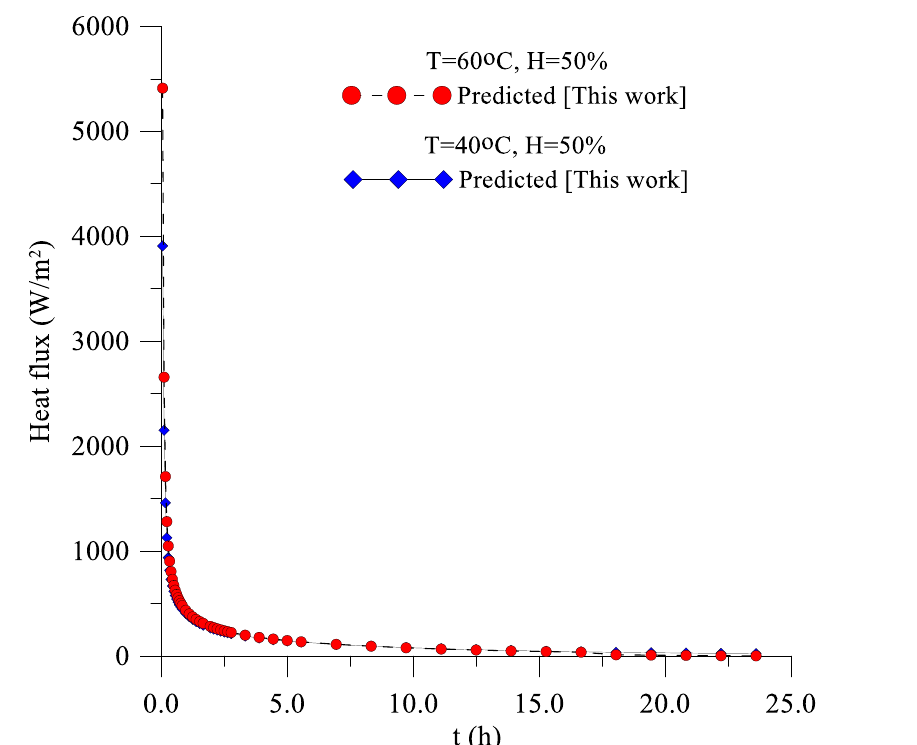
◦ C and a relative humidity of